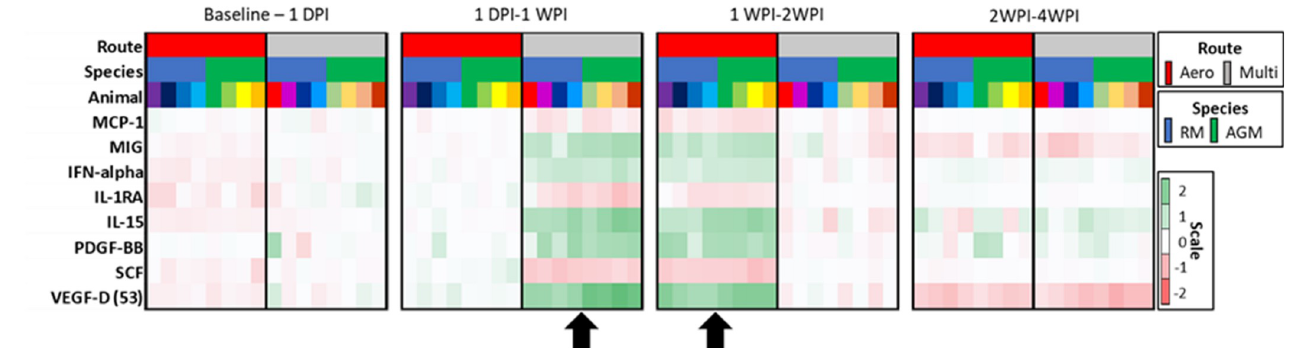
Fig 5. Heat map of BAL cytokine expression dynamics. Changes in the cytokine expression between time points demonstrates the delayed cytokine kinetics in the aerosol cohort (red). Similar dynamics are observed in both cohorts (arrows) occurring between 1 day post infection (DPI) and 1 week post infection (WPI) in the multiroute cohort compared to 1–2 WPI in the aerosol cohort.